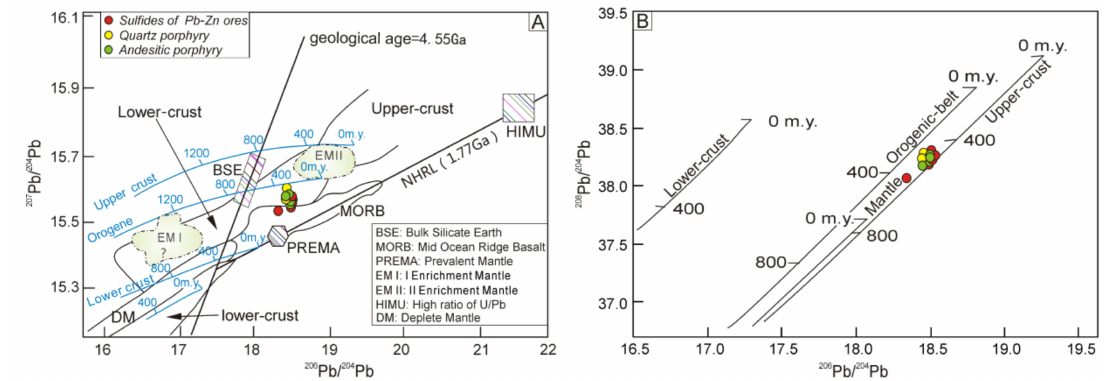
Figure 9. ( A ) 207 Pb / 204 Pb versus 206 Pb / 204 Pb diagram for the andesite porphyry, and ( B ) 208 Pb / 204 Pb versus 206 Pb / 204 Pb for the quartz porphyry in the Erdaohezi deposit (the base diagrams are from